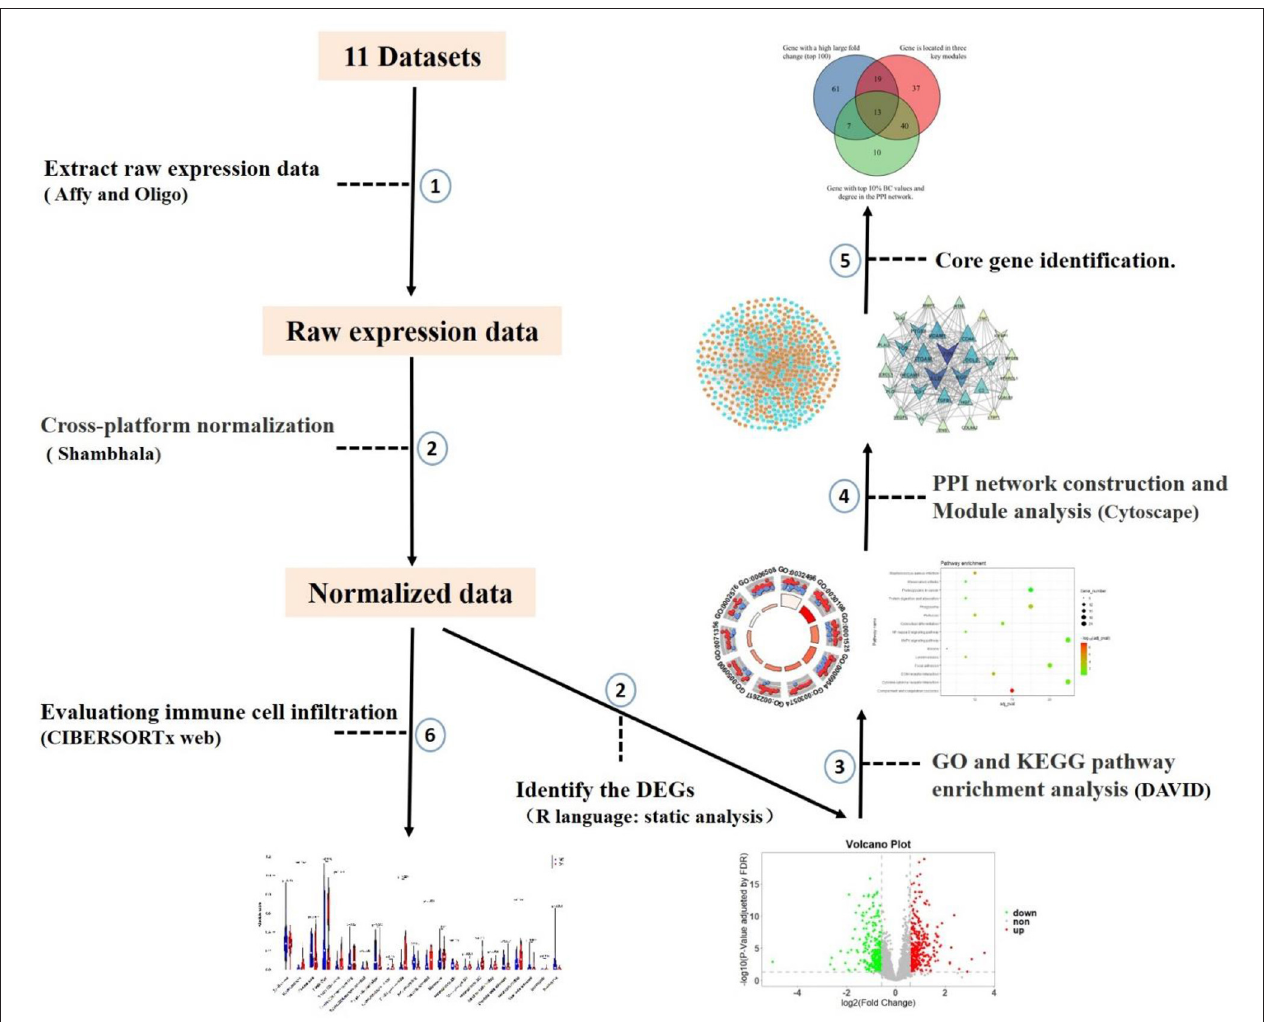
FIGURE 1 | The workflow of microarray data preprocessing and subsequent analysis in this study. We selected 11 datasets based on the constraints. Firstly, raw expression data were extracted after background correction and quality control. Processing was carried out using the R package, and then the data were cross-platform normalized by coordination and transformation using Shambhala. Then DEGs of DN glomerular tissue and healthy control tissue were identified by static analysis. Enrichment results were obtained using DAVID, then PPI networks and modules were constructed, and core genes were identified. Finally, the dataset was brought into the CIBERSORTx web portal to evaluate immune cell